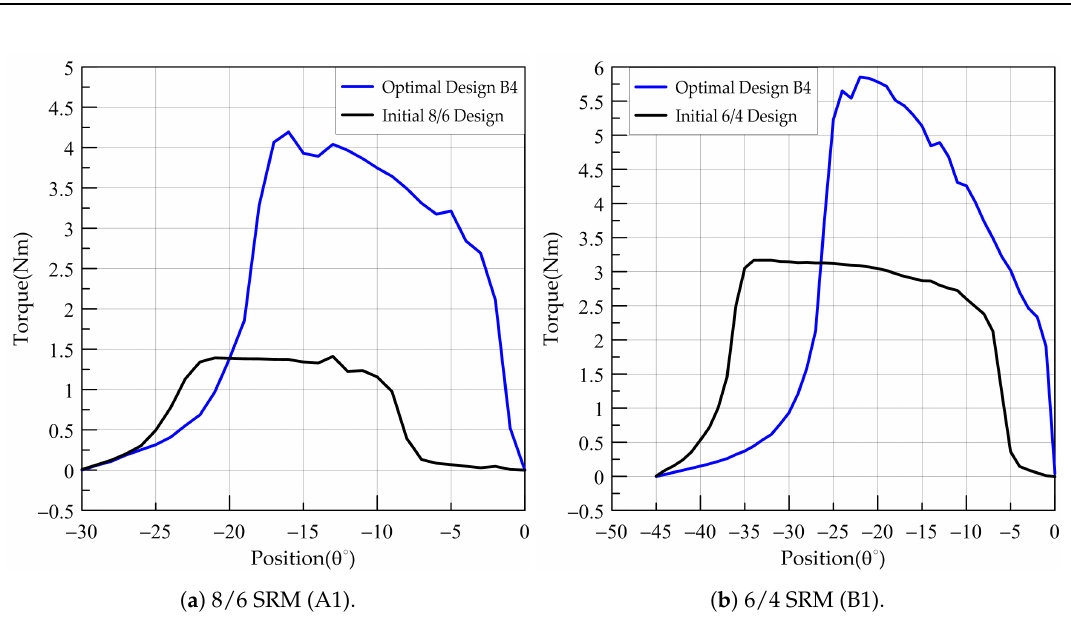
Figure 9. Torque per phase of initial and optimal SRM